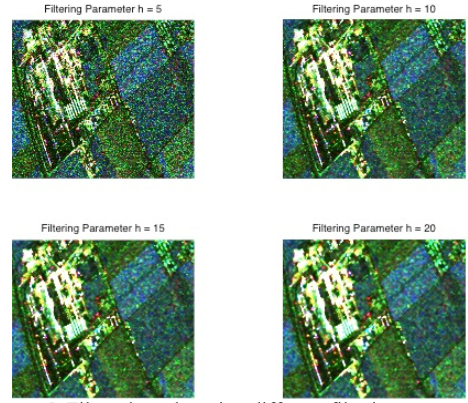
Figure 5. Filtered results using different filtering parameters Piecewise kernel